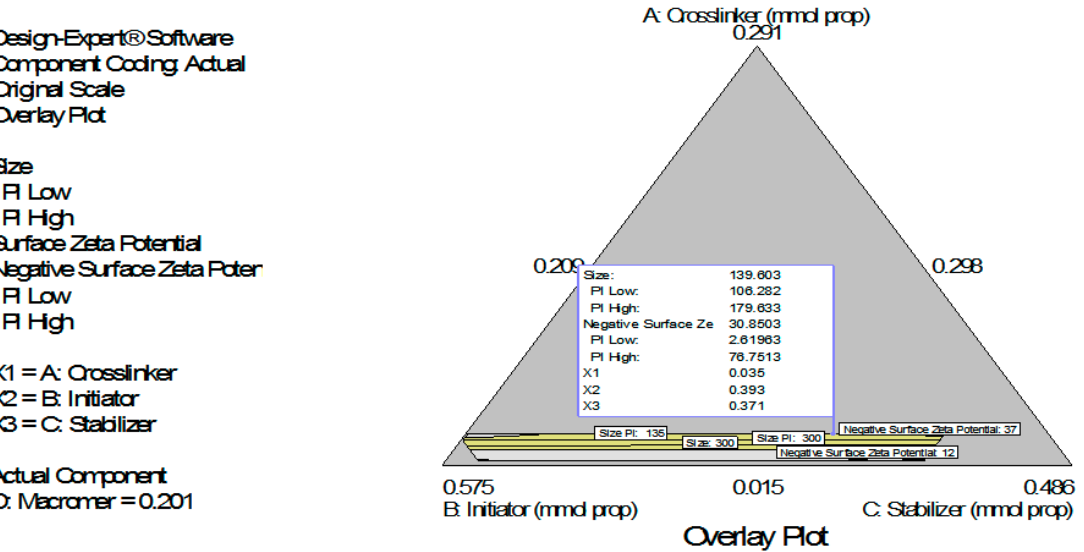
Figure 11. Simultaneous graphical optimization (overlay plot) of the design space variation in particle size and zeta potential as functions of the mixture composition. A = crosslinking agent; B = initiators; C = stabilizer and D = macromonomer.